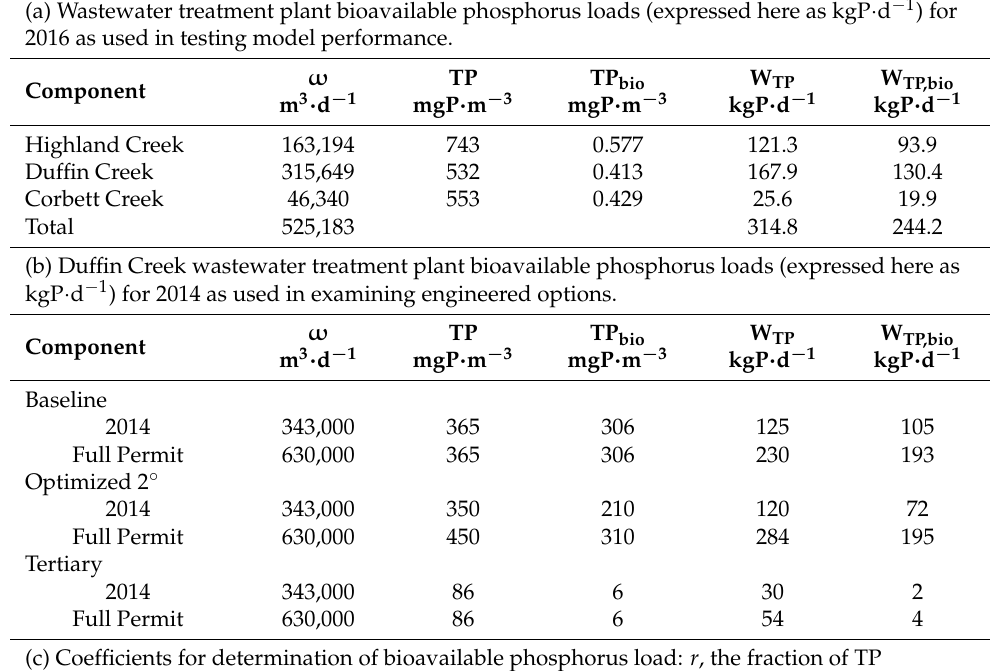
Table 2. Effluent characteristics and coefficients used in calculating total and bioavailable phosphorus